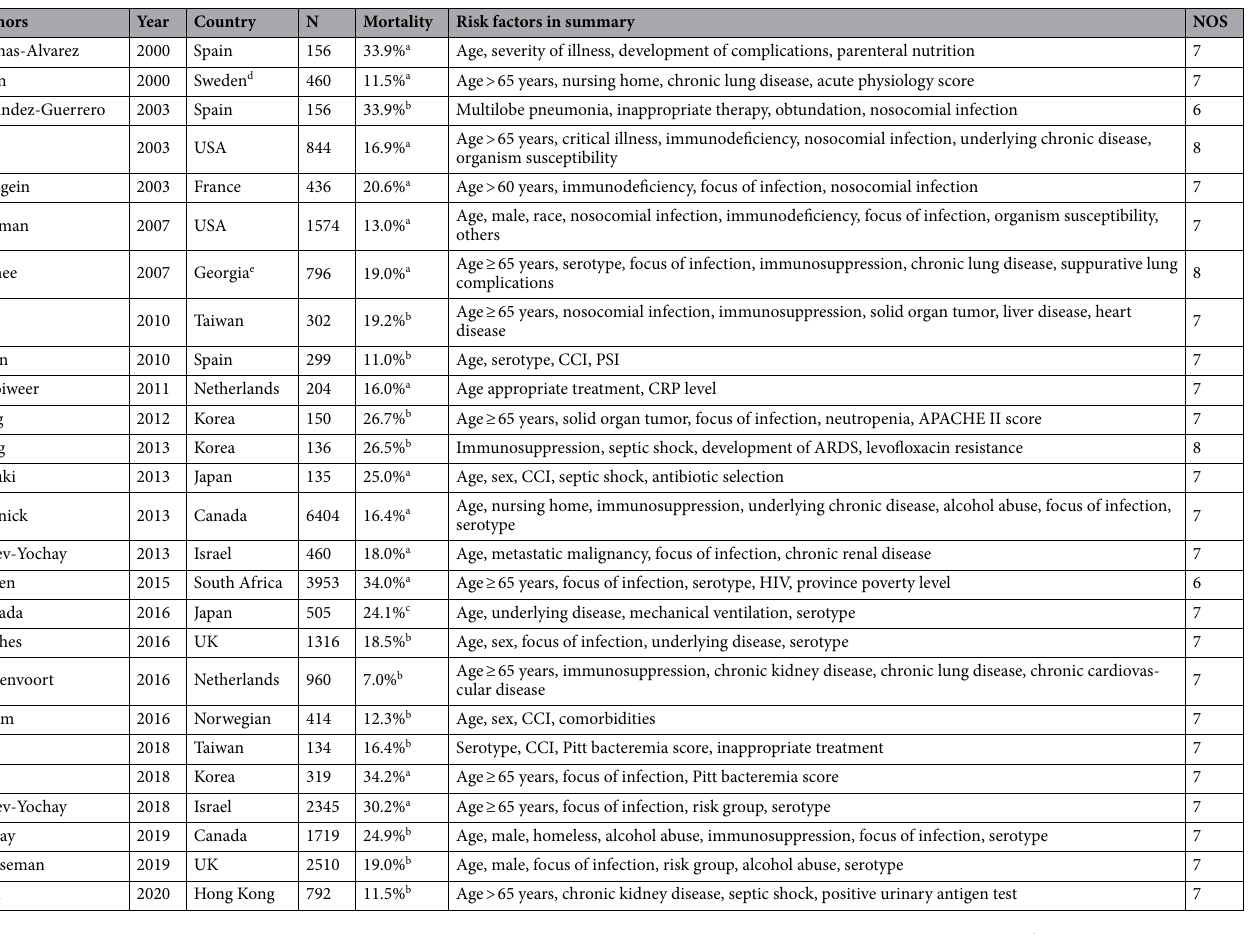
Table 1. Background characteristics of the 26 studies included. a in-hospital mortality; b 30-day mortality; c 28-day mortality. d United States of America, Canada, Spain, United Kingdom, Sweden. e South Africa, United States of America, Sweden, Spain, New Zealand, Taiwan, Argentina, Brazil, Hong Kong, and France. NOS: Newcastle–Ottawa Scale score; score ranges from 0 (worst) to 9 (best).